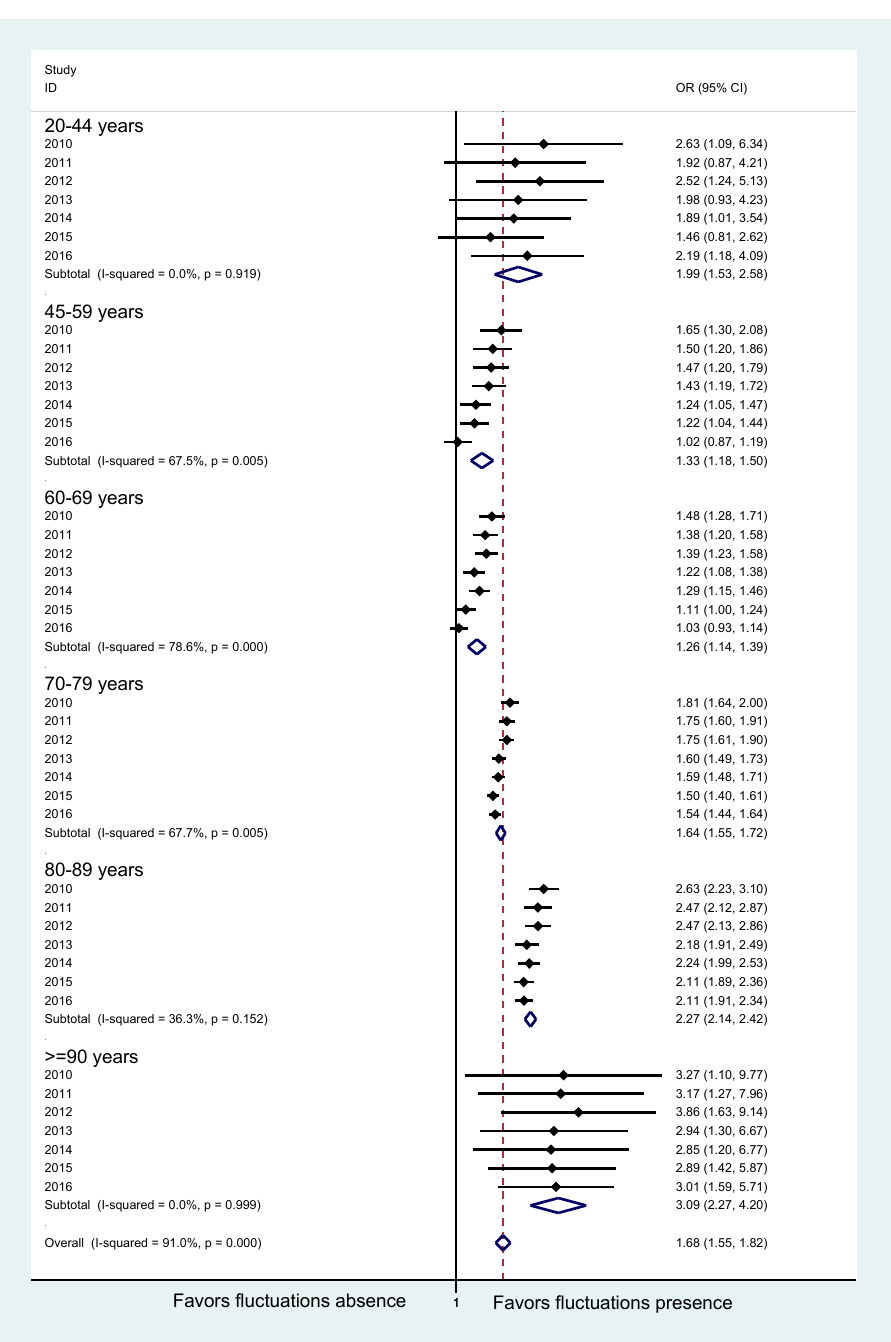
9 Figure 4. PD-MCT rates for primary Parkinson syndrome from 2010–2016 stratified by age group. Horizontal bars depict percentages and 95% confidence intervals (CI) to receive PD-MCT in relation to all stationary PD treatments in specified years for predefined age groups. Diamonds depict